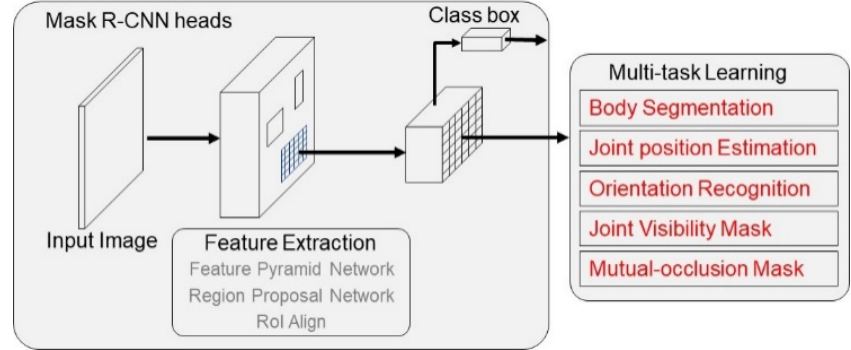
Figure 1. The framework of the proposed multi ‐ task based pose estimation model.